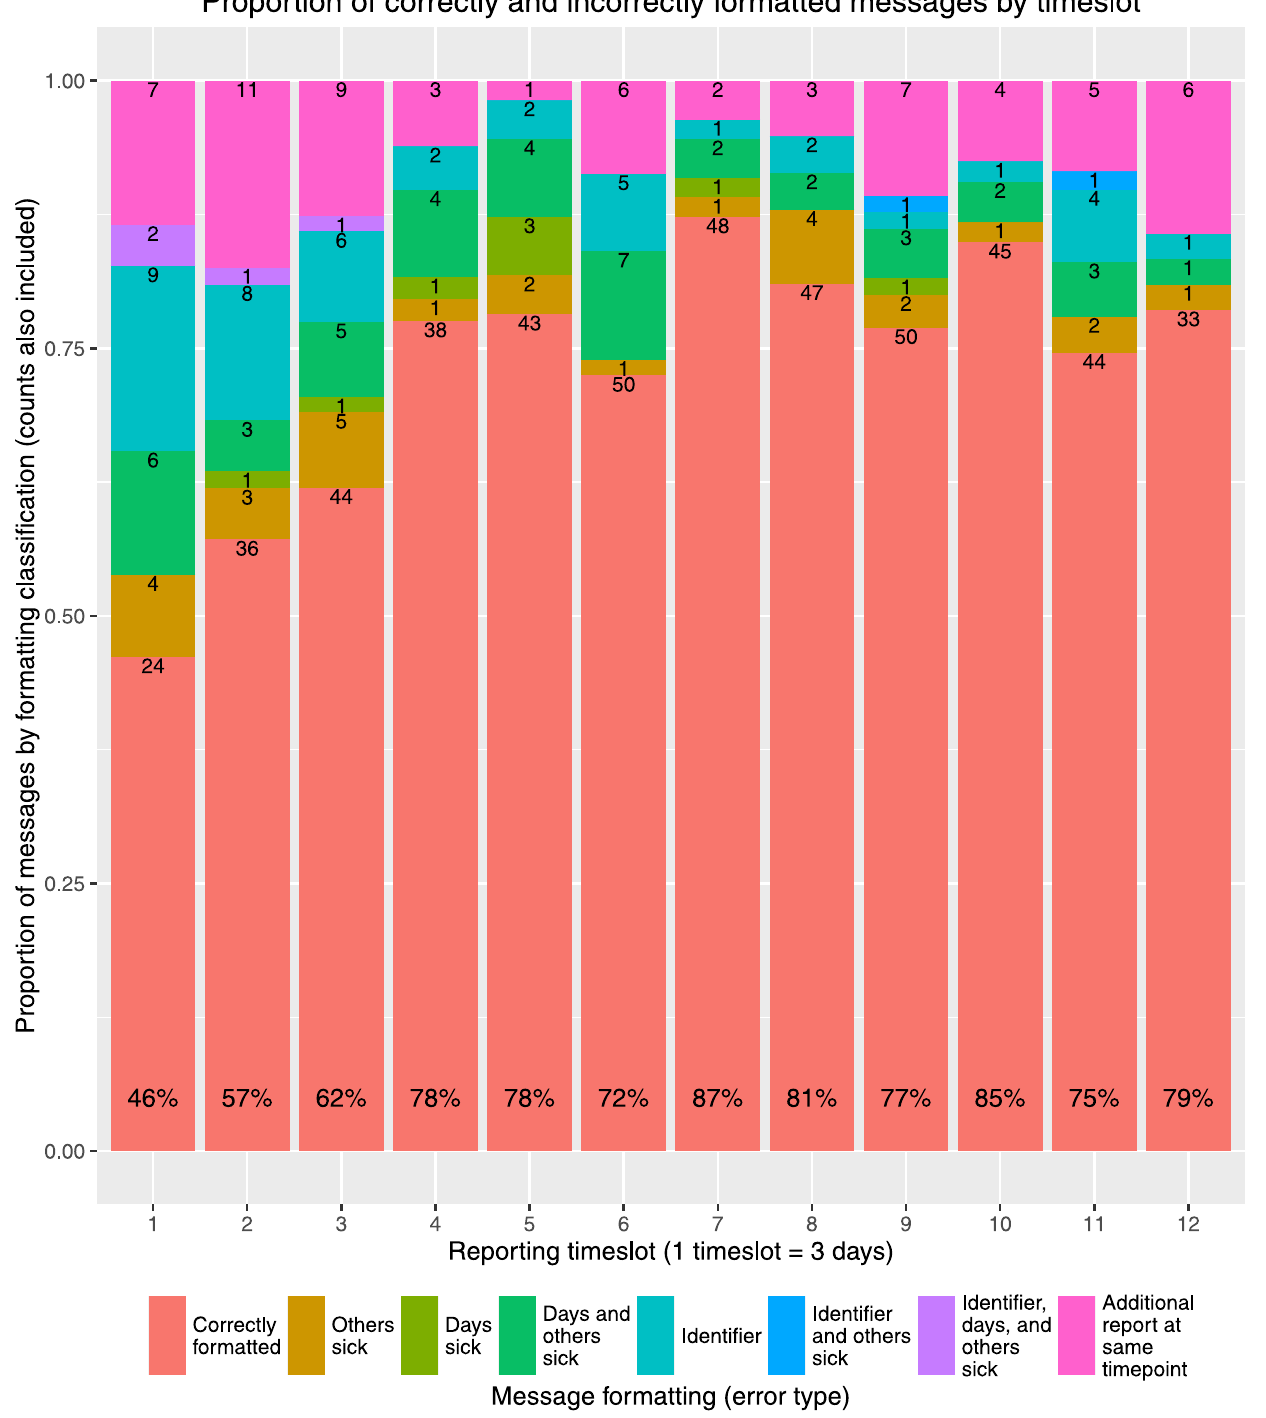
Fig 2. Overview of participant reporting behaviour. Basic breakdown of message formatting at each timestep, with total percentage correct at the base of each bar.